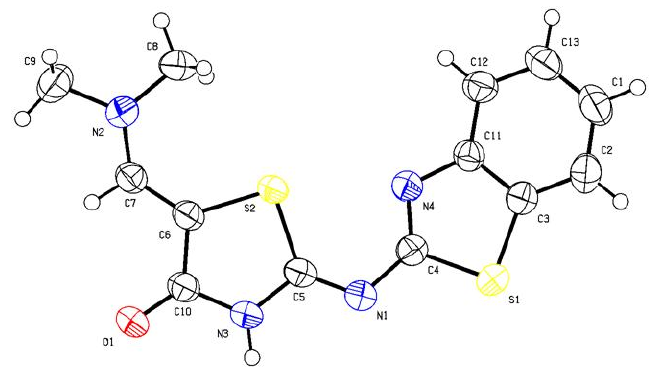
Figure 6. ORTEP plot of the X-ray crystallographic data determined for 8b . Crystallo- graphic data have been deposited with the Cambridge Crystallographic Data Centre as supplementary publication number CCDC 874404 [35].